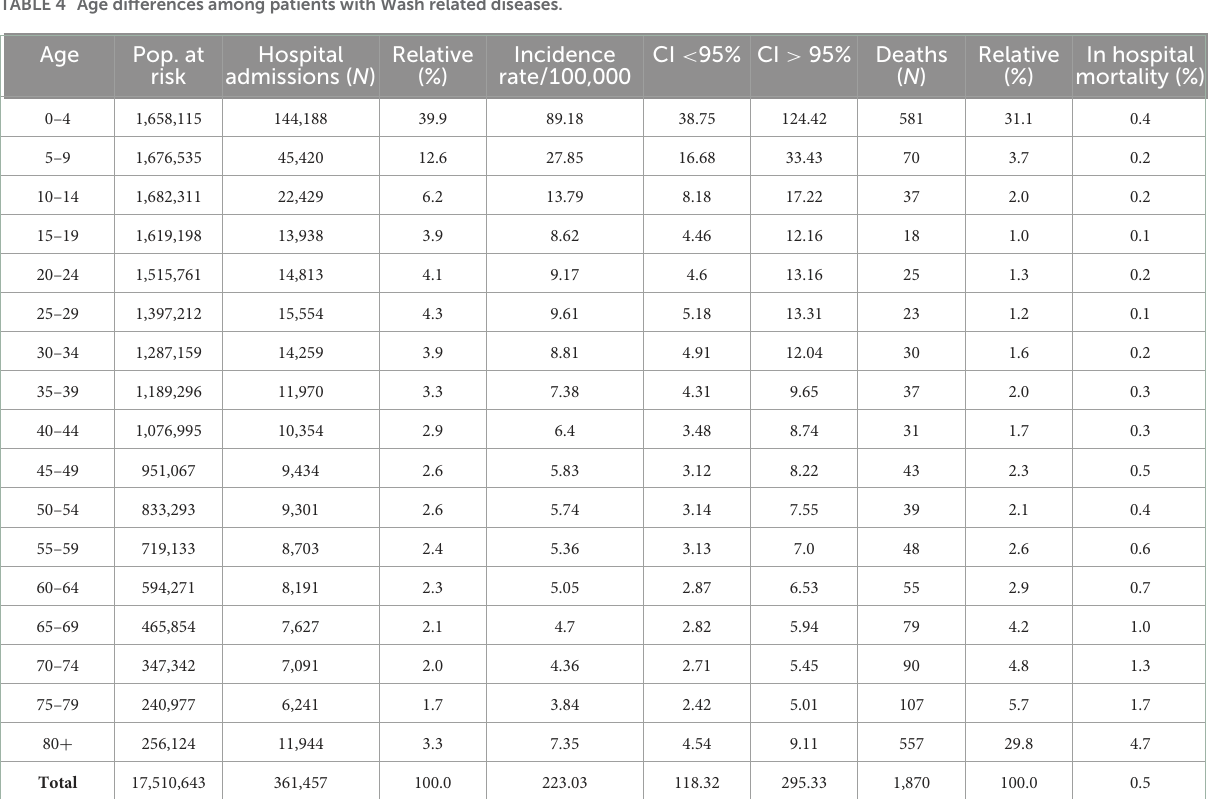
TABLE 4 Age differences among patients with Wash related